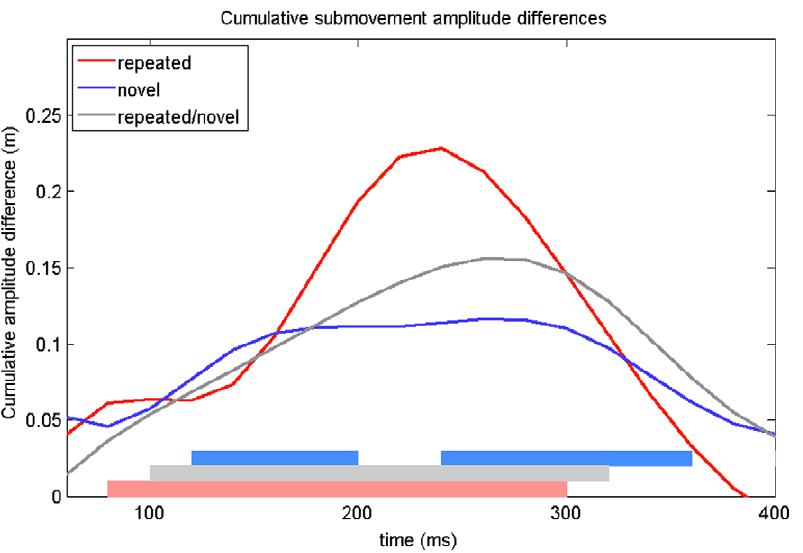
Figure 8. Submovement cumulative amplitude differences from Experiment 2. The difference (incongruent – congruent) in the mean cumulative submovement amplitude is plotted. The shaded regions along the x-axis indicate when the 95% confidence intervals calculated over the difference scores do not include zero.